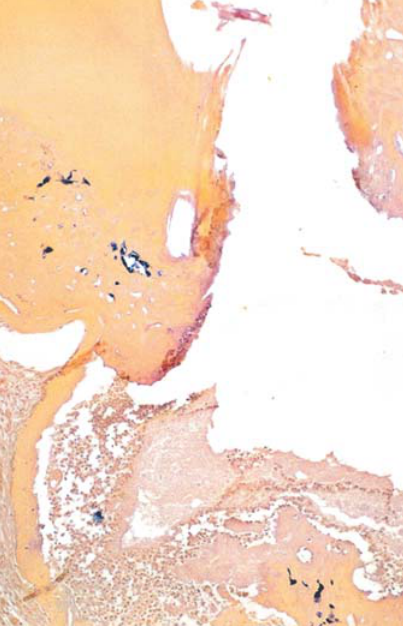
FIGURE 6- Microorganisms in the superficial cementum and periapical region, Brown & Brenn - 125X